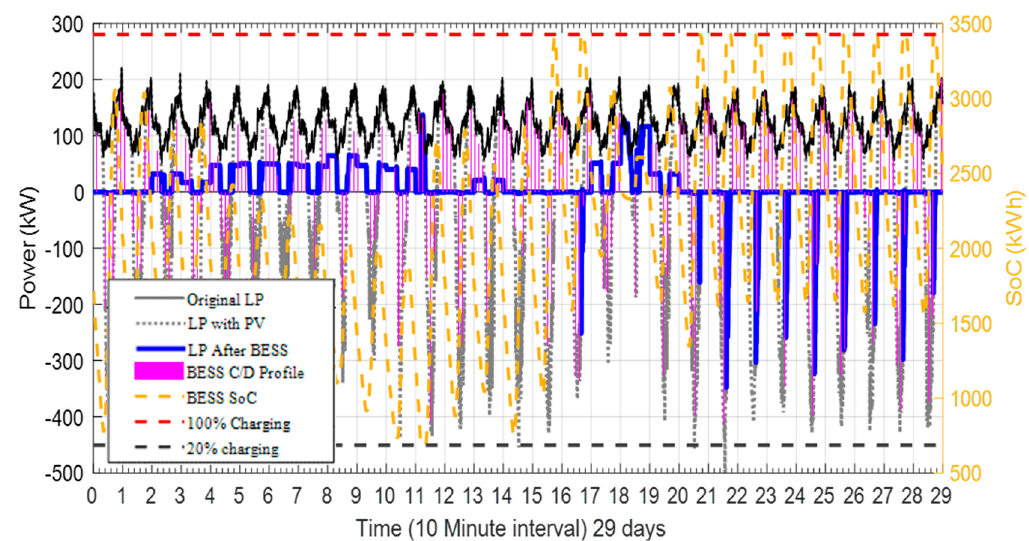
Figure 16. Load profiles for 100% PV penetration and BESS for RPFS with AD = 0.2 (1–29 February 2016).